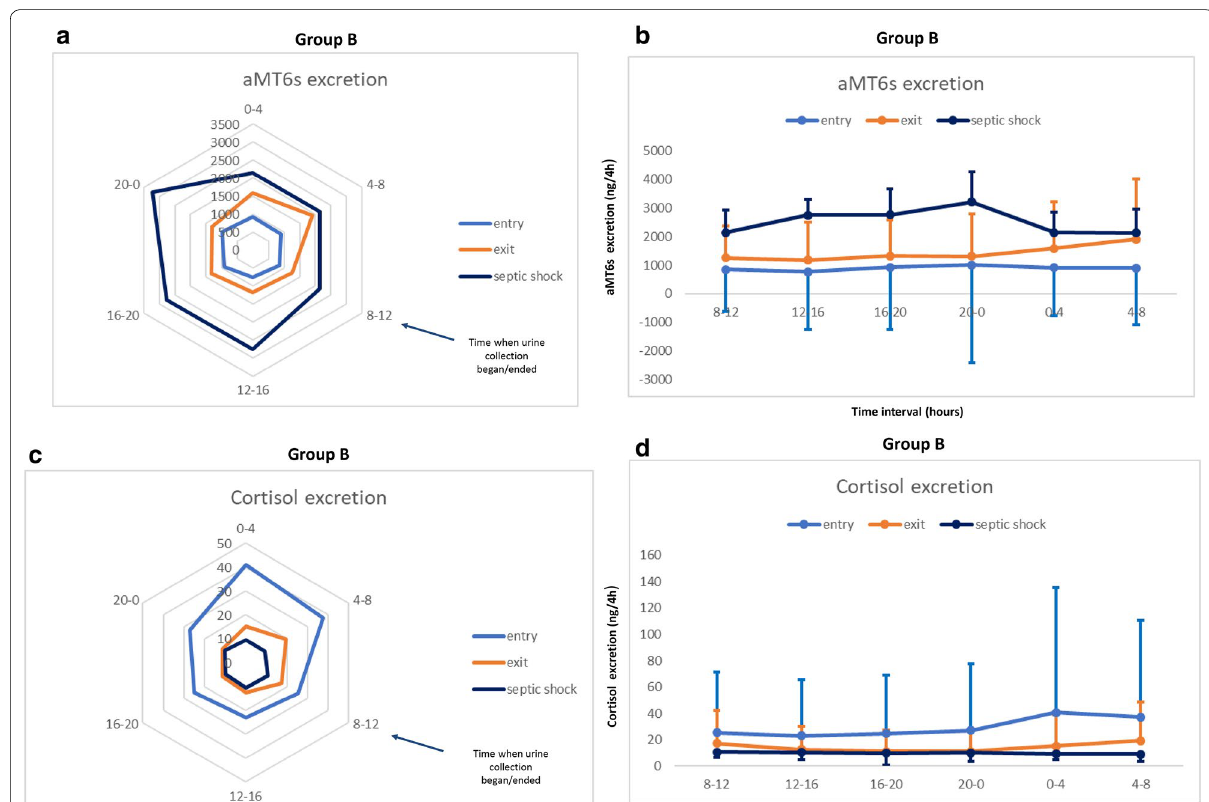
Fig. 3 Radar plots and longitudinal trends of aMT6s and cortisol urine excretion in patients who developed septic shock during ICU admission (Group B). a Radar plots of urinary aMT6s excretion mean values (ng) per 4-h intervals upon entry, septic shock and exit and within a 24-h period in patients who developed septic shock during ICU admission ( N 11). The value 0 corresponds to midnight. The blue arrow indicates when urine = collection began/ended for all patients. aMT6s 6-sulfatoxymelatonin. b Longitudinal 24-h profiles of urinary aMT6s excretion mean values per 4-h = intervals upon entry, septic shock and exit in patients who developed septic shock during ICU admission. Error bars represent standard deviations (SDs). The value 0 on x axis corresponds to midnight. aMT6s 6-sulfatoxymelatonin. c Radar plots of urinary cortisol excretion mean values per = 4-h intervals upon entry, septic shock and exit and within a 24-h period in patients who developed septic shock during ICU admission. The value 0 corresponds to midnight. The blue arrow indicates when urine collection began/ended for all patients. d Longitudinal 24-h profiles of urinary cortisol excretion mean values per 4-h intervals upon entry, septic shock and exit in patients who developed septic shock during ICU admission. Error bars represent standard deviations (SDs). The value 0 on x axis corresponds to